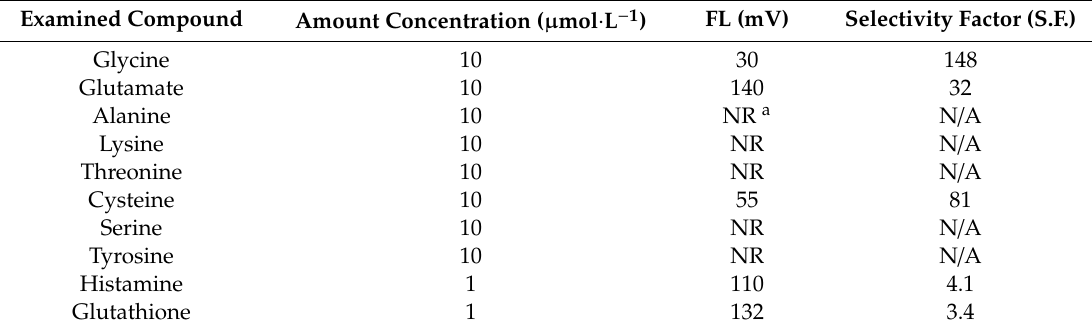
Table 2. Selectivity of the proposed method.